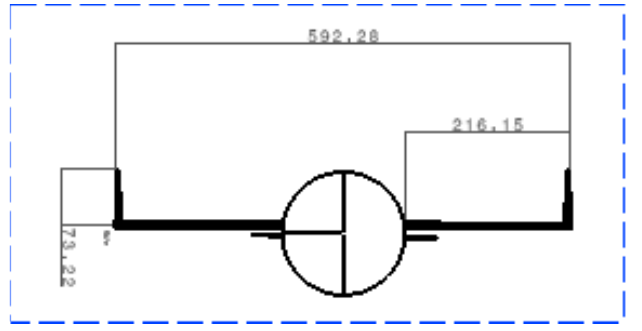
Figure 31. Design of optimised UAV—A typical view—1.